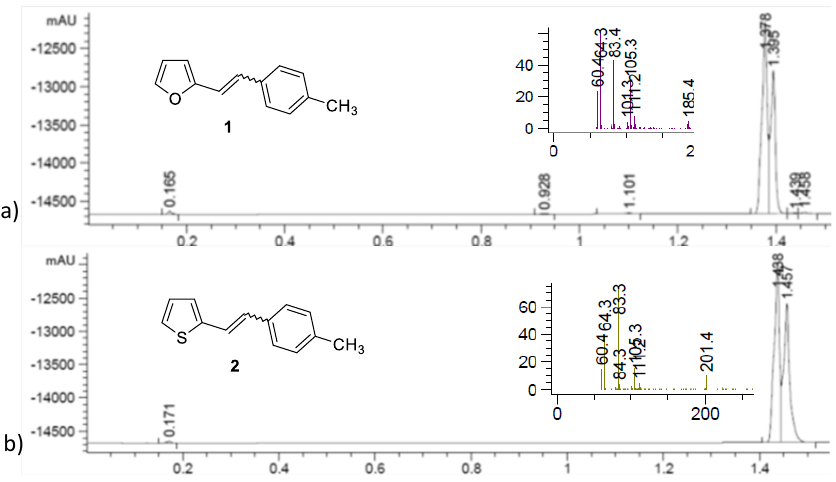
Figure 4. DAD chromatograms of the mixture of isomers of the starting furyl derivative 1 ( a ) and thienyl derivative 2 ( b ) along with the retention times and mass spectra.